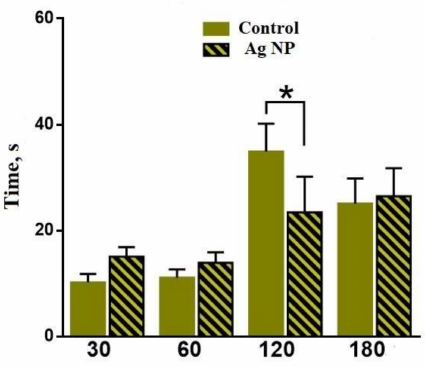
Figure 8. Latent time for different periods of the experiment. The reliable difference can be seen for 120 days.